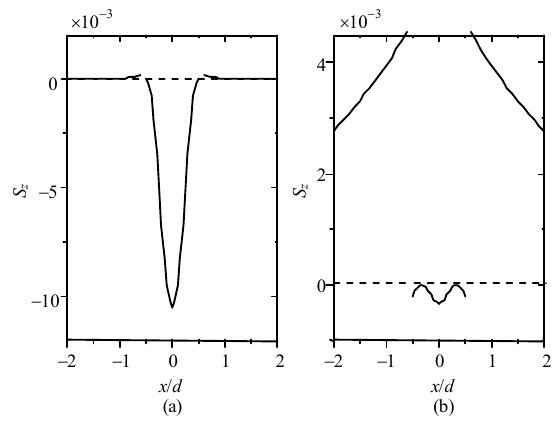
Fig. 4 Energy flux